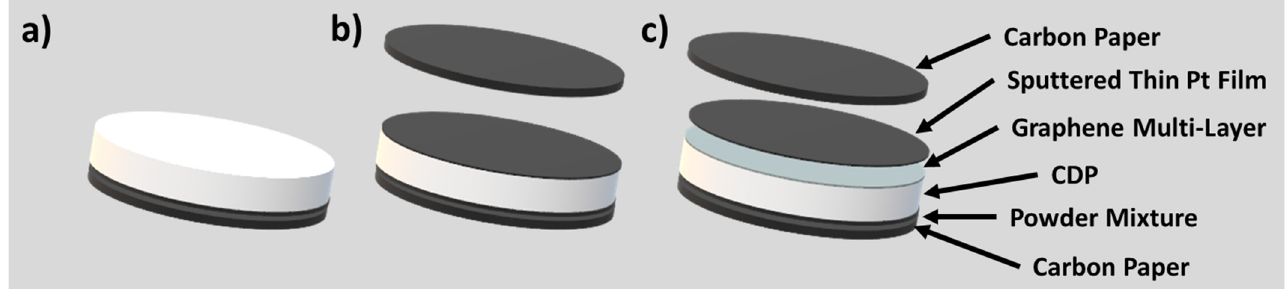
Scheme 1. A cartoon showing the Pt SP cell fabrication: before ( a ) and after ( b ) the sputtered thin Pt film and ( c ) the sputtered thin Pt film in the presence of graphene separator.